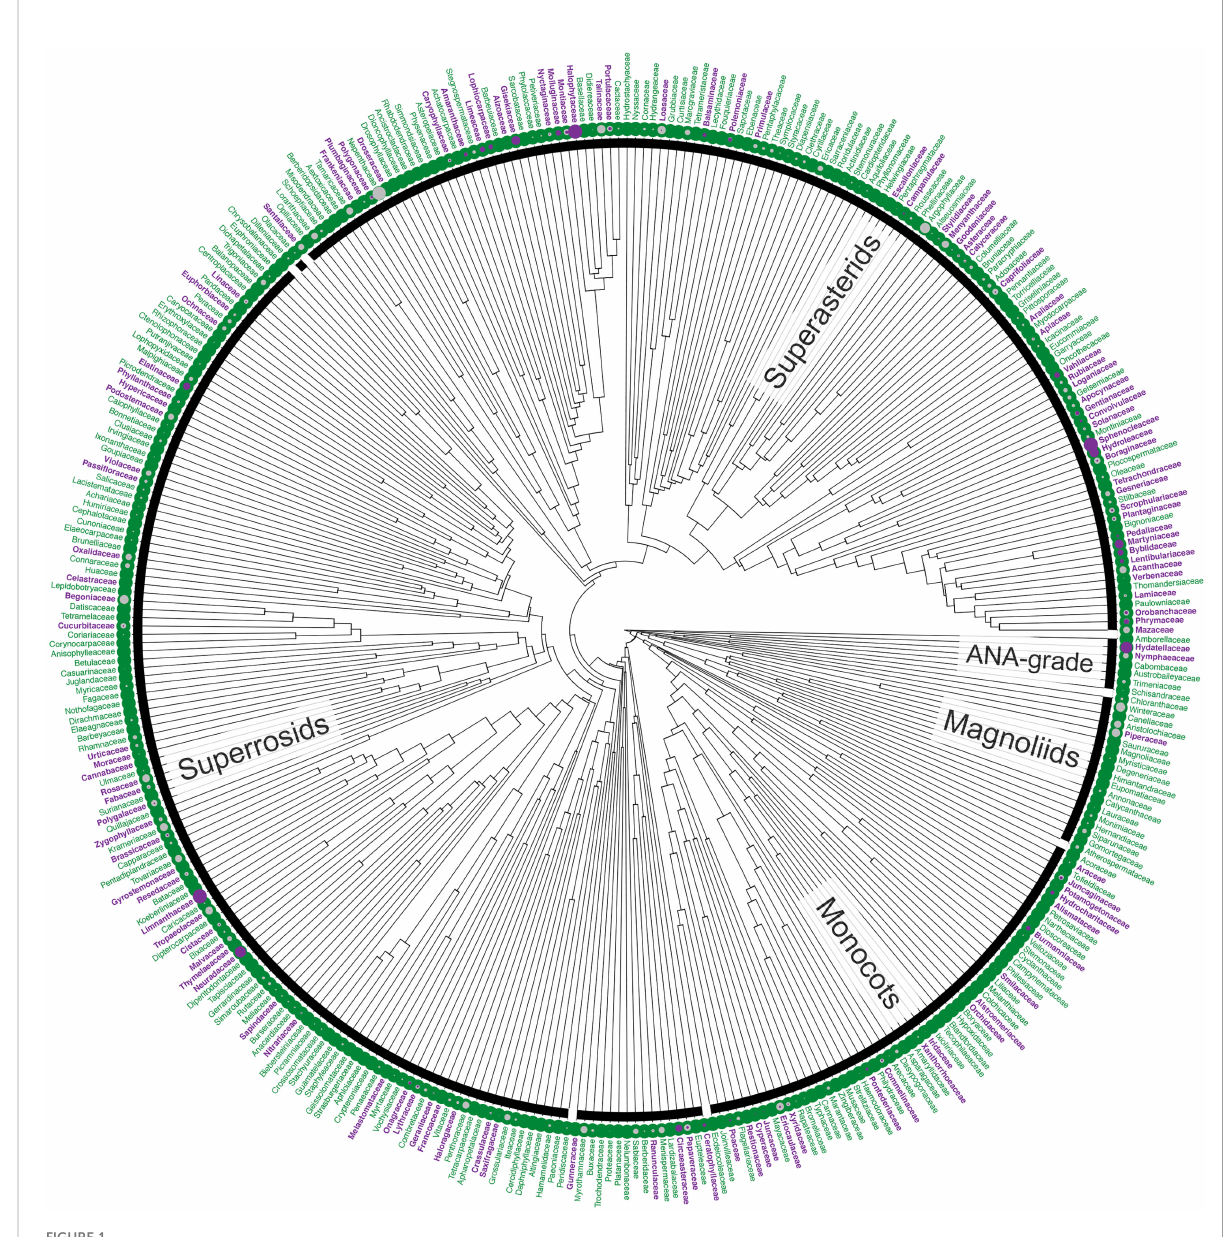
FIGURE 1 Distribution of annuals among angiosperm families. Families are shown in purple if at least one constituent species is annual; families consisting entirely of perennials are shown in green. Filled circles represent the proportion of the species in a family that is annual (purple) or for which life history data are missing (unknown; grey). The highest numbers of annual species are found in three, large families but the proportion of annuals in these families is not exceptional (Asteraceae, 7%; Fabaceae, 5%), although higher for Poaceae (17%). However, the highest proportions overall are found in small families comprising fewer than 10 species, including the monotypic Halophytaceae (Caryophyllales, Superasterids), Limnanthaceae (Brassicales, Rosids) and Neuradaceae (Malvales, Rosids). Tree based on Magallo ́ n et al. (2015); data based on WCSP (2018) and extended upon using the literature and consultation with experts (Supplementary material I, II). The de fi nition of annuals used in this fi gure includes terrestrial, aquatic and polymorphic species plus those scored as ‘ biennials ’ in the literature (see Footnote